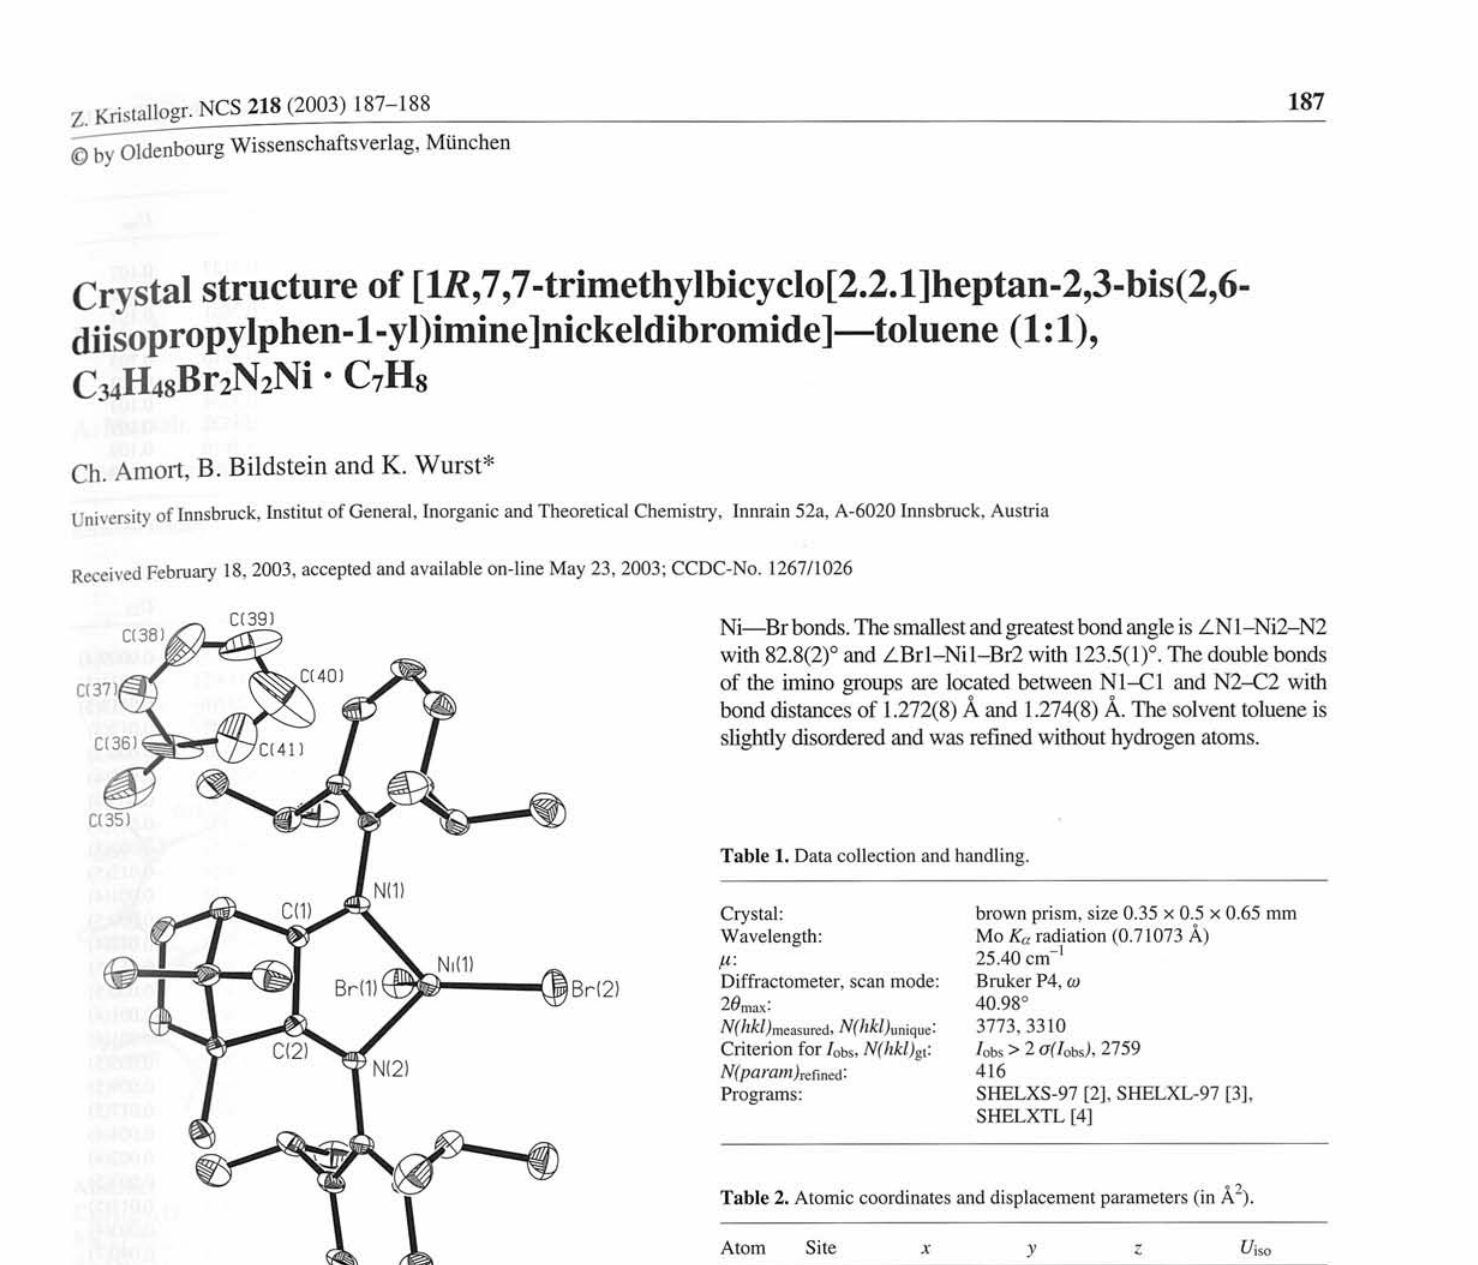
Table 2. Atomic coordinates and displacement parameters (in A